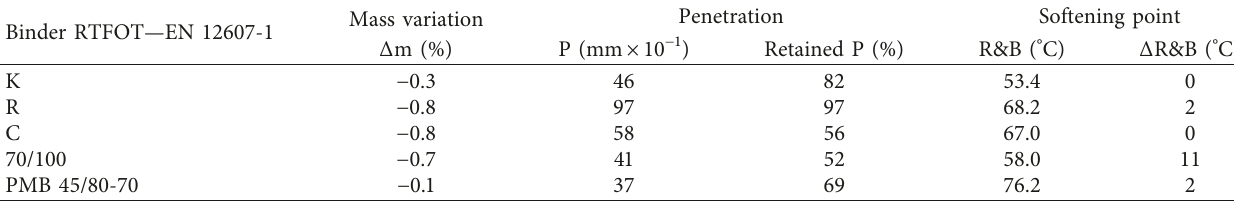
Table 1: Effect of short-term ageing with RTFOT on tested binders. Binder RTFOT—EN 12607-1